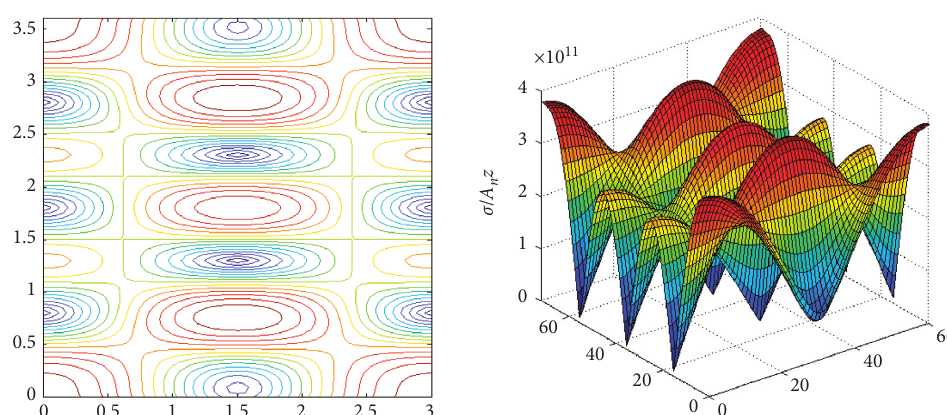
Figure 14: The maximum shear of the 10 th order mode